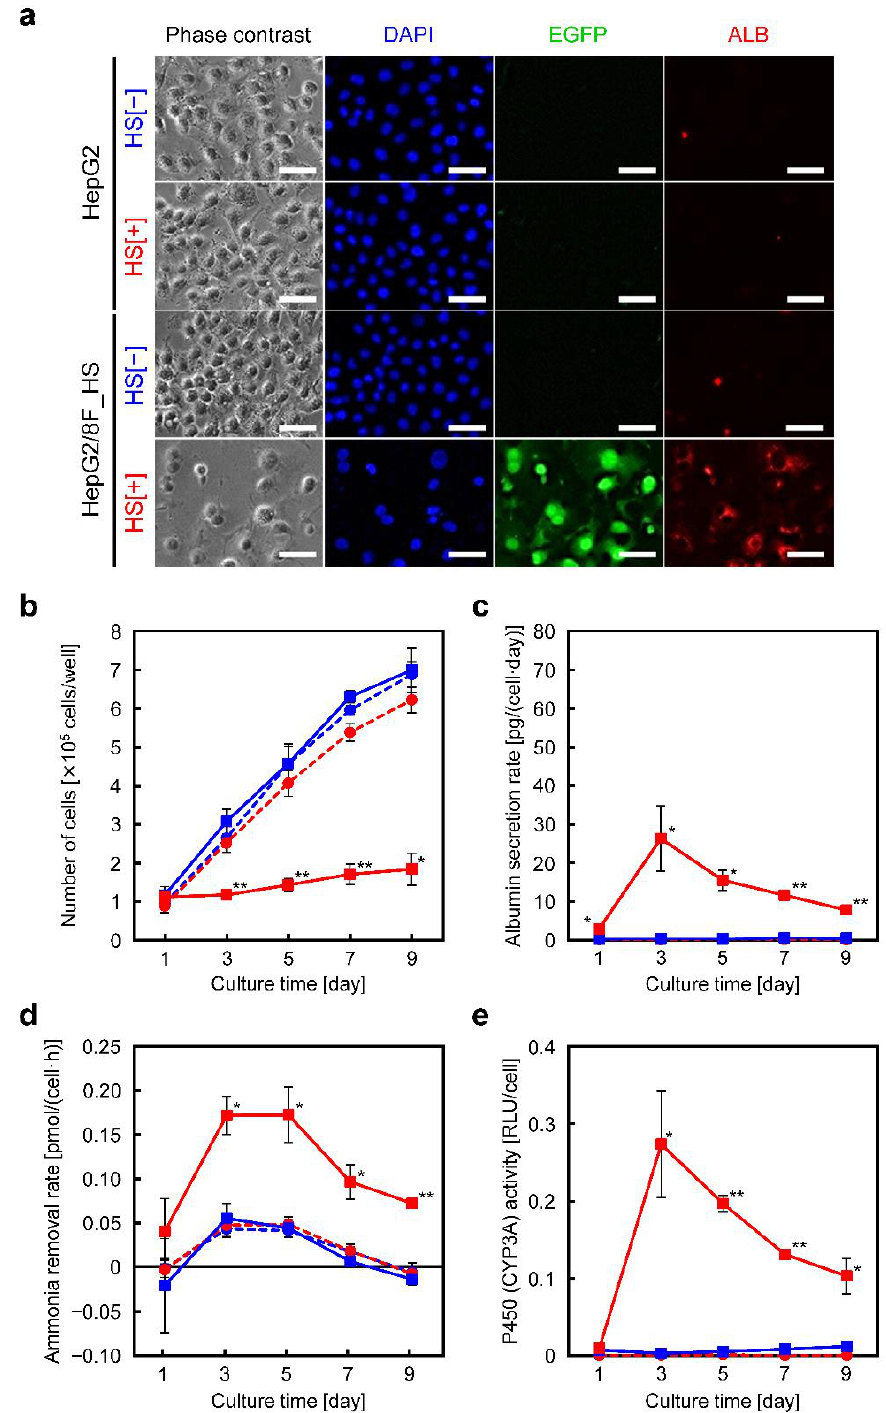
Figure 2. Morphological observations and liver function analyses of HepG2 and HepG2/8F_HS cells in monolayer culture: ( a ) Phase contrast and fluorescence images of HepG2 and HepG2/8F_HS cells with (HS[+]) or without (HS[−]) heat treatment. DAPI, nuclei; EGFP, enhanced green fluorescent protein; ALB, albumin. Scale bars = 50 µm. ( b – e ) Liver function analyses during the culture of HepG2 (circles) and HepG2/8F_HS (squares) cells. The number of cells ( b ), albumin secretion rate ( c ), ammonia removal rate ( d ), and cytochrome P450 (CYP3A4) activity ( e ) were measured. HS[ − ], blue symbols; HS[+], red symbols. Data are presented as means ± standard deviations ( n = 3); * p < 0.05, ** p < 0.01 vs. HS[−].